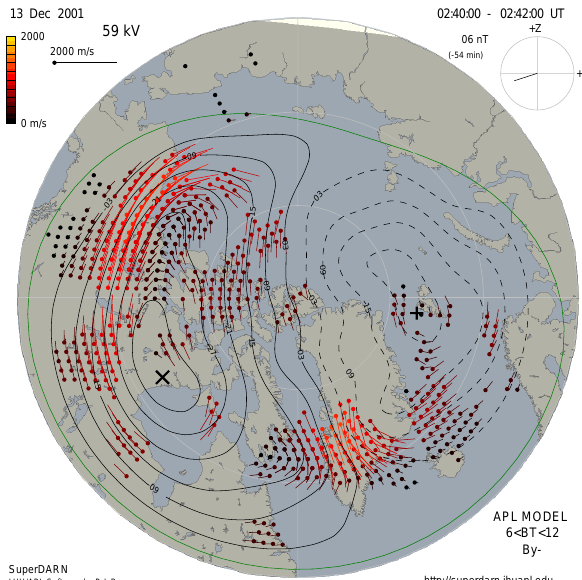
Fig. 3. Contours of the SuperDARN electric potential pattern for 02:40UT on 13 December 2001. The short lines indicate the iono- spheric drift velocities measured by the radars with their lengths and colours representing the drift magnitude and their orientations indicating the direction of